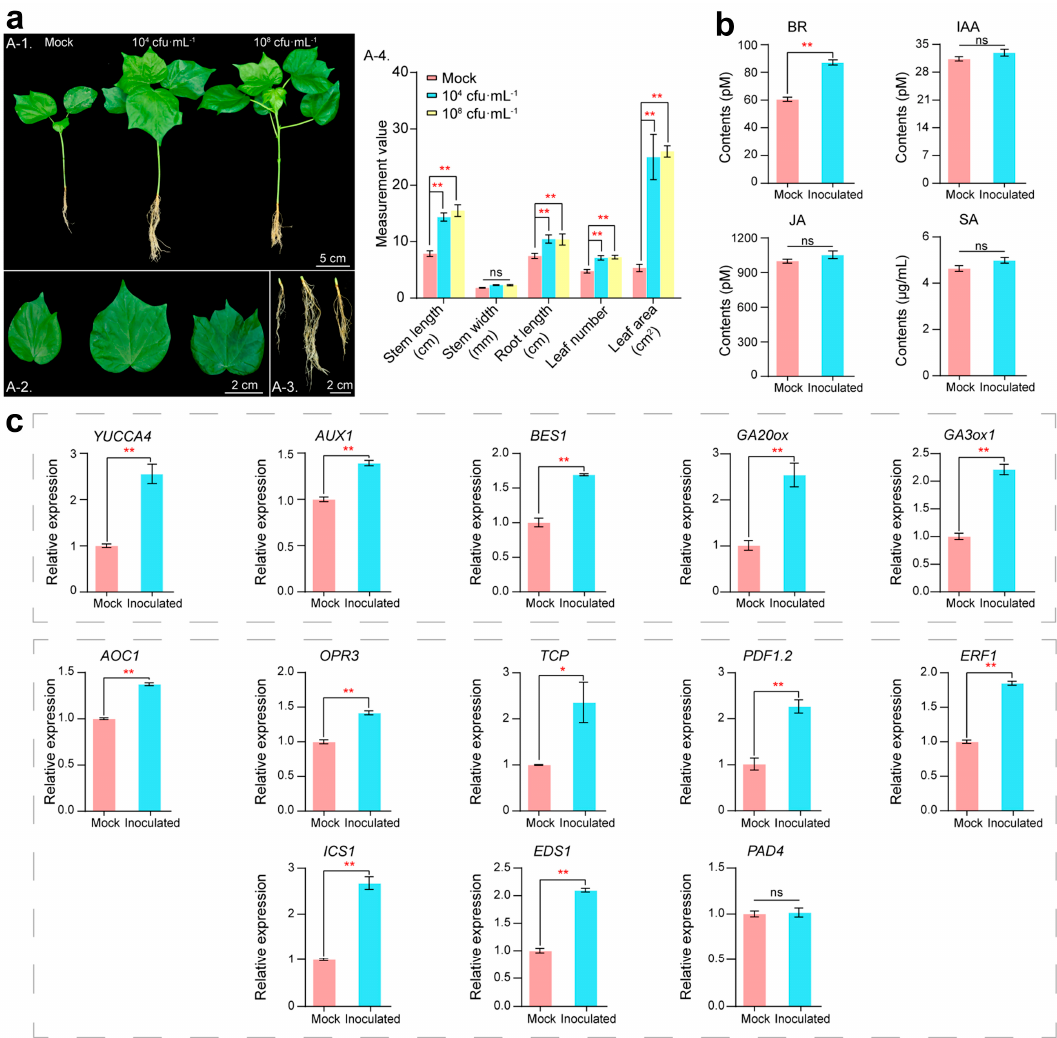
Figure 2. Phenotypic changes in cotton 30 days after inoculation with B. paralicheniformis RP01. ( a ) The changes in phenotype of the whole plant (A-1), enlarged leaf (A-2) and enlarged root (A-3). Plant biomass data (A-4). Leaf area is measured as the area of the third leaf from the top bud. Treatment groups from left to right are the mock, 10 4 cfu/mL and 10 8 cfu/mL groups. ( b ) Hormone content of cotton leaves. ( c ) Hormone-related genes by RT-qPCR. Error bars represent standard error (SE). Statistical significance was calculated using one-way analysis of variance (ANOVA) followed by Bonferroni’s post hoc test. The asterisk (*) indicates a significant difference at p < 0.05; (**) indicates p < 0.01.